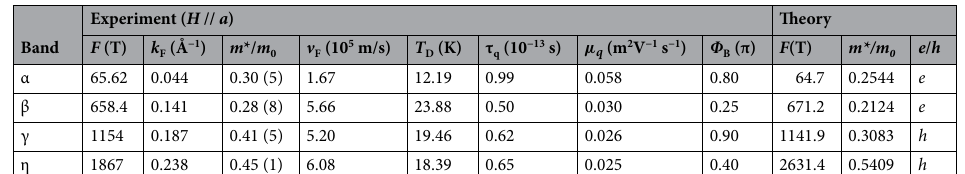
Experiment ( H // a ) Band